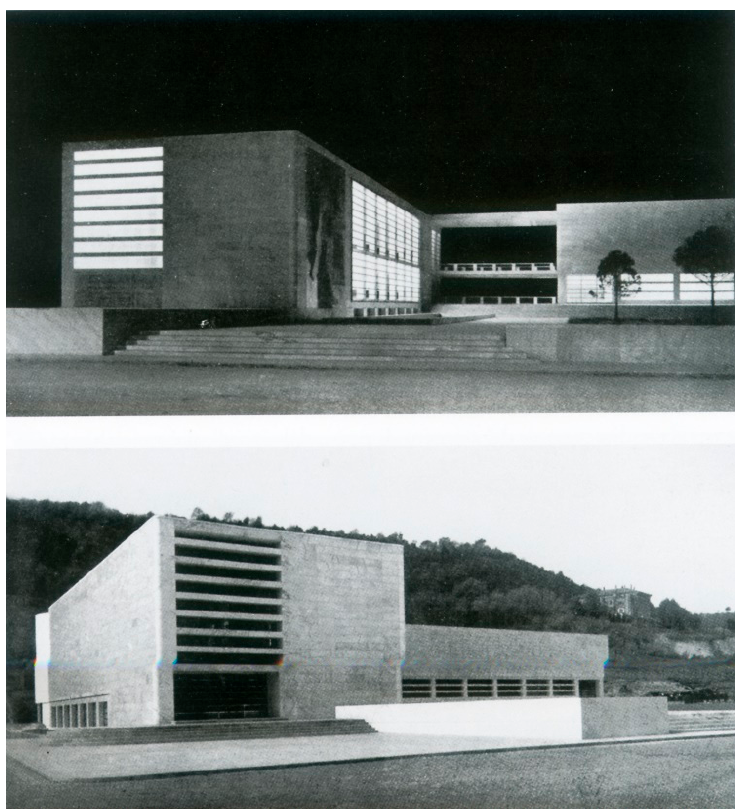
Figure 17. House of Arms of Luigi Moretti. Rome (1933–1936). The block of the fencing room. Vertical covering in statuary veined Carrara marble. Photo from (Marconi 1937, pp. 440, 443).